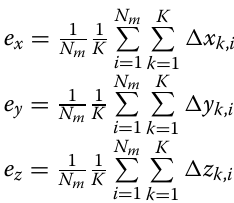
position of sensors in the ECEF reference system. The